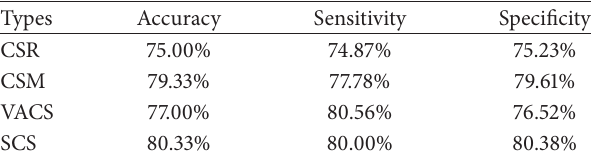
Table 7: Testing results: accuracy, sensitivity, and